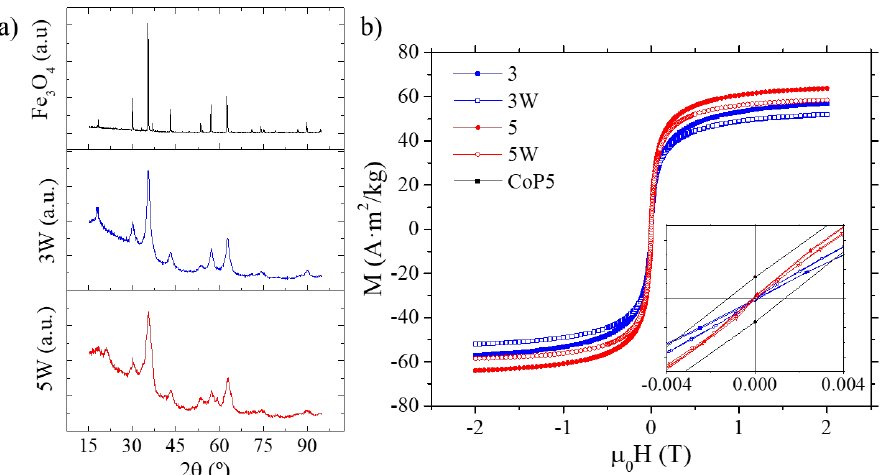
Figure 4. ( a ) XRD spectra obtained from the samples 3W and 5W compared with the magnetite pattern Puritronic ® . ( b ) Magnetization curves at room temperature for the samples 3 and 5 before (3, 5) and after the washing procedure (3W, 5W). Inset: central area detail of the magnetization curves for the samples obtained by co-precipitation, CoP5, and ME.